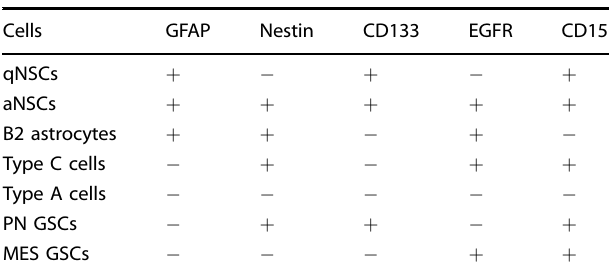
Table 3. Common gene signatures of NSCs